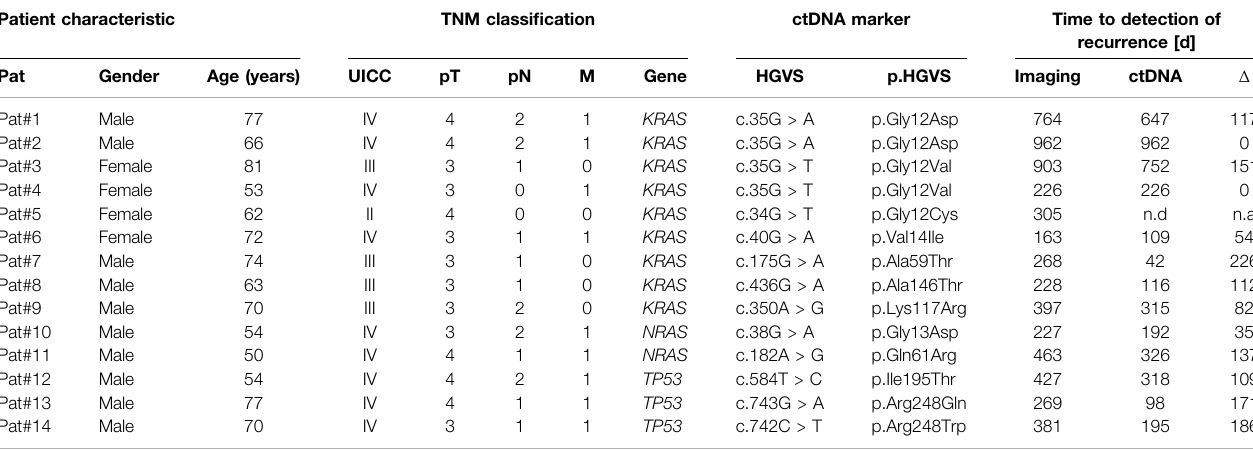
TABLE 1 | Retrospective validation of ctDNA-based detection of